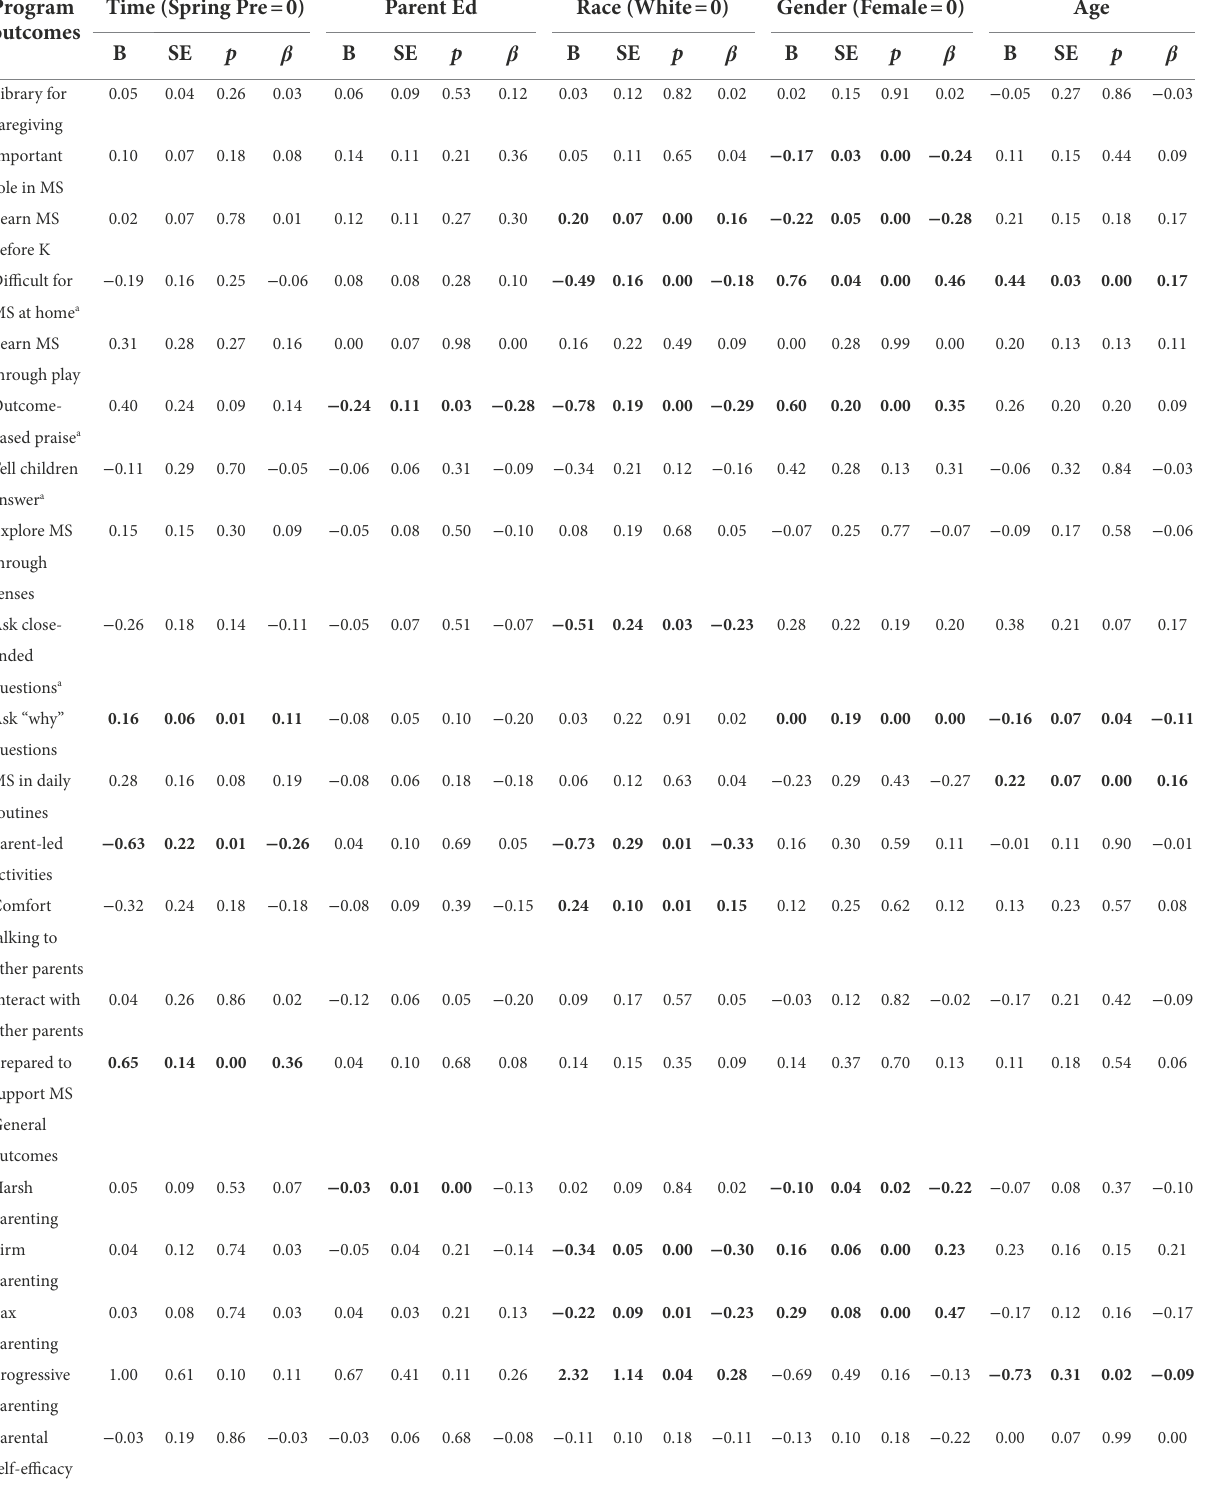
Bold indicates significant findings, a indicates negatively valanced program items, where decreases from pre-to post-test are